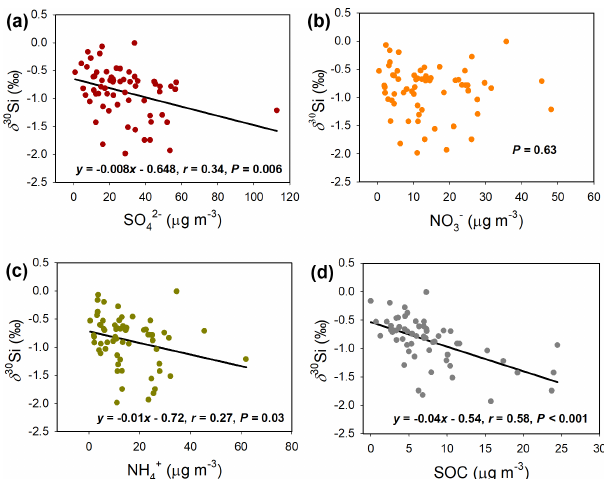
Figure 5. Correlation analysis of Si isotopic composition ( δ 30 Si) of PM 2 . 5 with the secondary species SO 2 − and SOC (d)